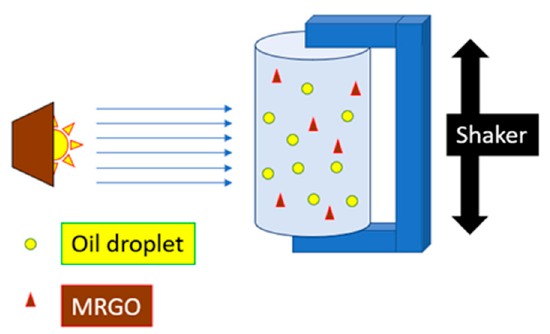
Figure 2. Schematic diagram of photocatalytic demulsification process.